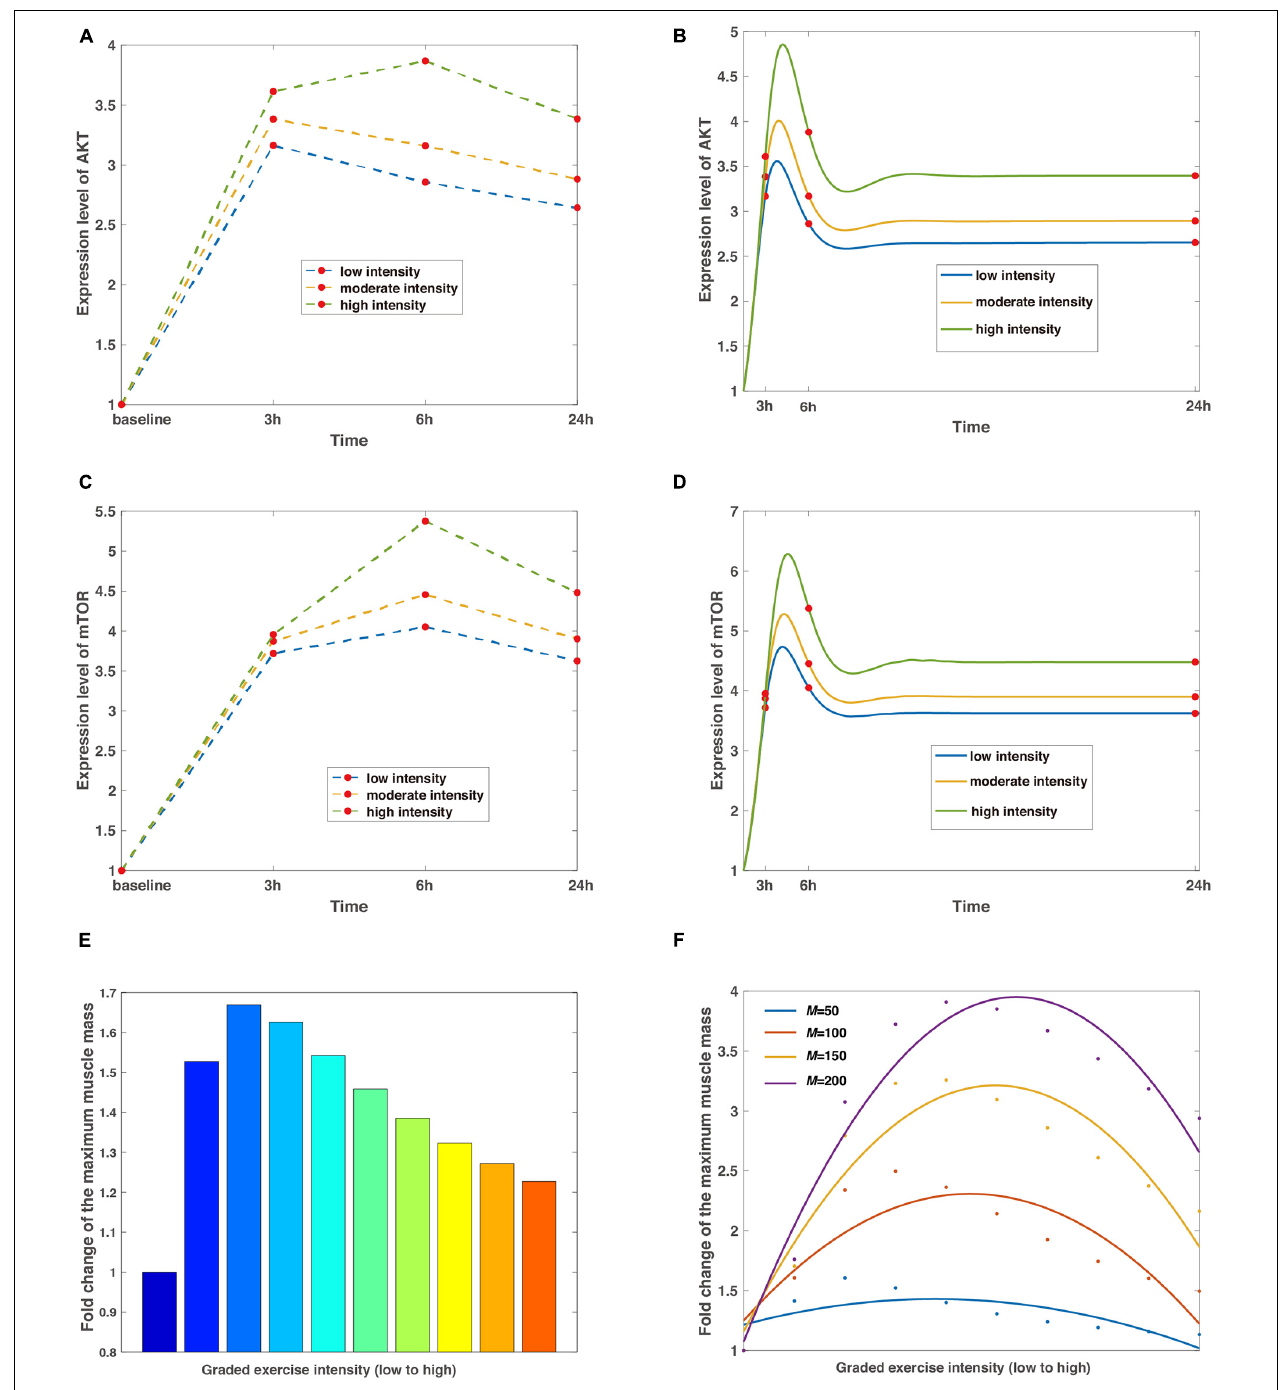
FIGURE 2 | The regulation of exercise intensity to the signaling pathways of AKT, mTOR, and muscle mass. (A,C) The discrete expression level changes of AKT and mTOR. The blue, tan, and green split lines represent low, moderate, and high intensities, respectively. Red dots mean the data are collected from baseline, 3, 6, and 24 h with basal values confirmed by control tests, which are characterized by steady expression levels of AKT and mTOR without exercise stimulations. (B,D) The continuous expression level changes of AKT and mTOR. Curves are the continuous dynamics of AKT and mTOR with colored lines of low, moderate, and high intensities, and red dots indicate data of a particular time step corresponding to (A) and (C) . (E) Non-monotonic relationship between exercise intensity and maximized muscle mass. The leftmost column depicts the control test without stimulation of exercise training, and the colormap displays a wide range of variations of intensity. (F) A predicted curve regarding intensity and muscle mass under different delay coefficients. Dots in blue, scarlet, tan, and purple represent raw data generated from simulations, whereas the corresponding smooth curves stand for the fitted lines in the quadratic functions. The average coefficients of determination R 2 = 0 . 7665 and the root-mean-square error RMSE = 0 . 2420.